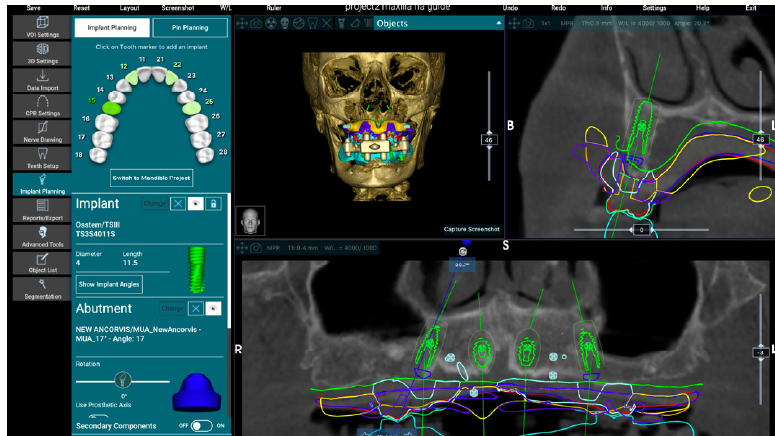
Figure 7. Virtual implant planning for maxillary All-on-4.